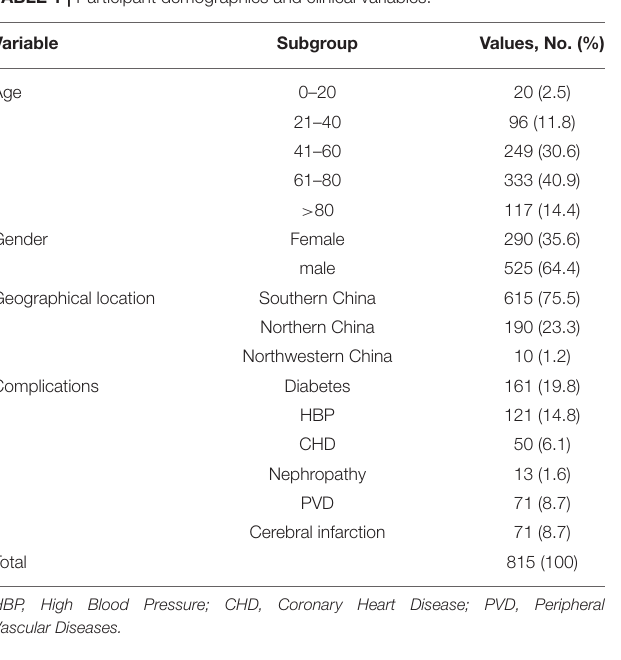
Frontiers in Medicine |